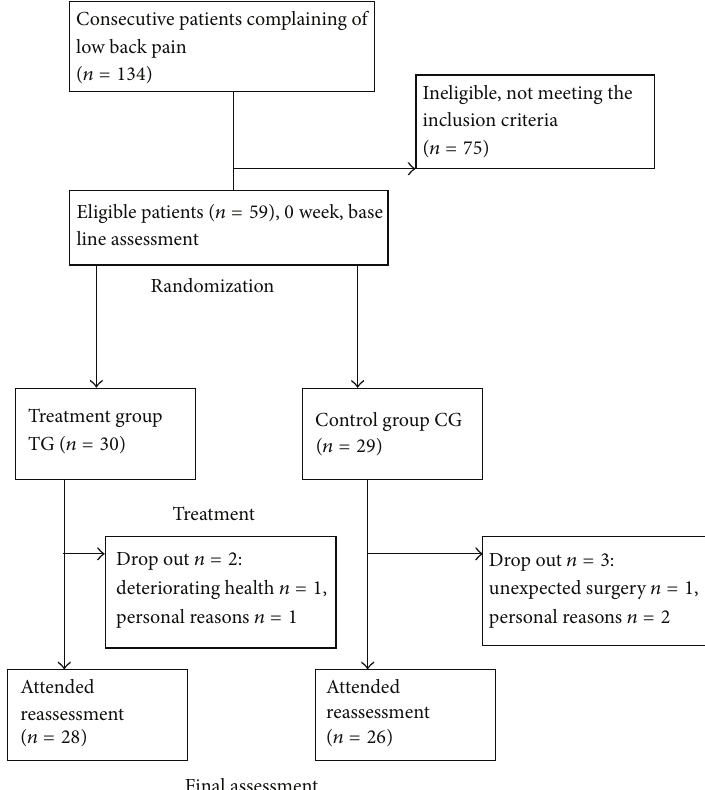
Figure 1: Flow of the participants through the